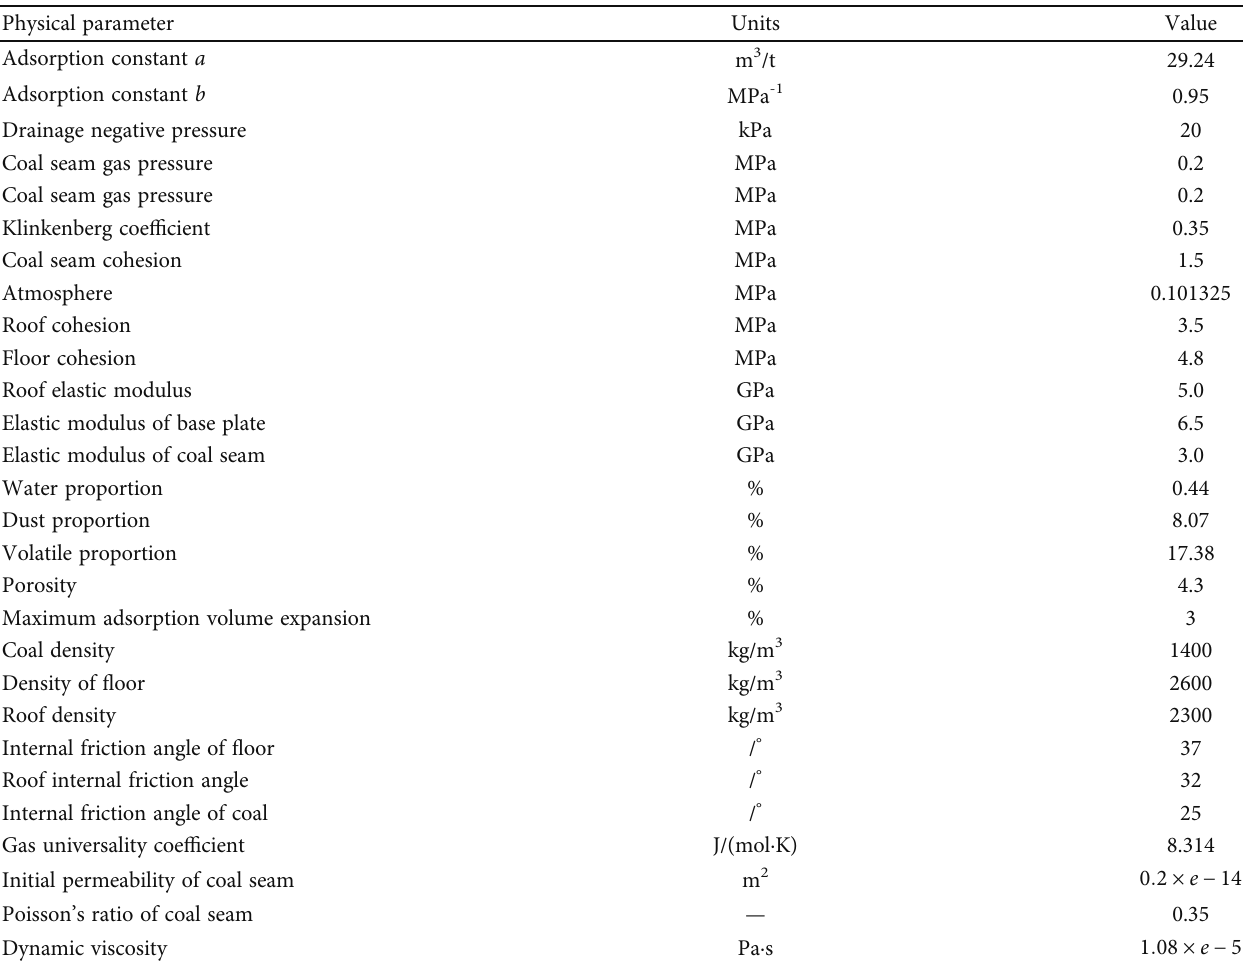
Figure 3: Geometric model of liquid carbon dioxide fracturing pumping. Table 1: Basic parameters of liquid carbon dioxide fracturing model for No. 2 coal